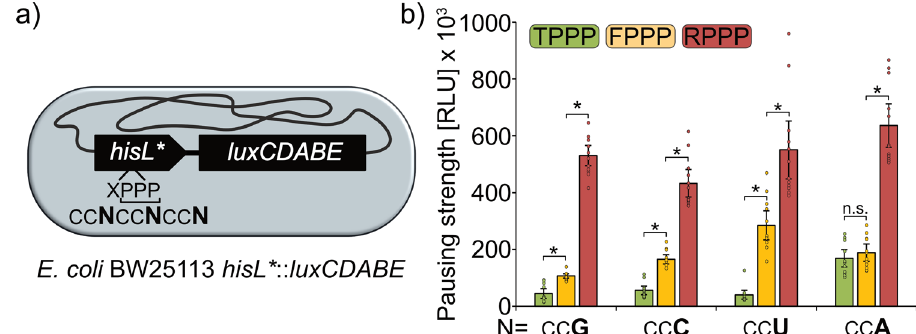
Fig. 5 Codon-dependent pausing strength at weak, intermediate, and strong PP-motifs. a Genomic organization of the HisL*_Lux reporter. Synthetic His- Leader peptides (HisL*) preceding the lux genes ( luxCDABE ) were genomically integrated at the his -locus. In hisL *, His1 one was replaced by a variable amino acid (X) to modulate pausing strength 16 . His2 through His4 were replaced by proline. In this regard several reporter strains (Supplementary data fi le S3) were generated with hisL* varying in the proline codon usage and are denoted as XPPP CC N where the underlined X designates the preceding amino acid and the bold N designates the wobble base used for encoding the proline residues. b HisL*_Lux carrying PP-motifs of varying pausing strength (weak — TPPP: green; intermediate — FPPP: yellow; strong — RPPP: red) with different proline codon usage were chromosomally integrated in E. coli BW25113 and tested for maximal luminescence emission. n = 12, Error bars indicate 95% con fi dence intervals. Data for CCG codons are duplicated from Fig. 5 for better overview. Statistically signi fi cant differences according to unpaired two-sided t -tests ( p value < 0.05) are indicated